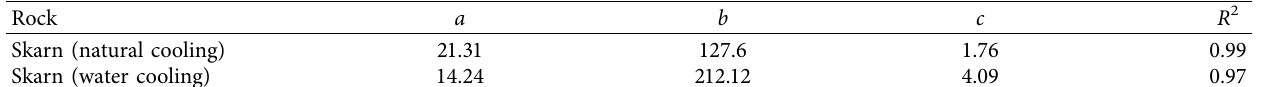
Table 10: Parameter table of fitting